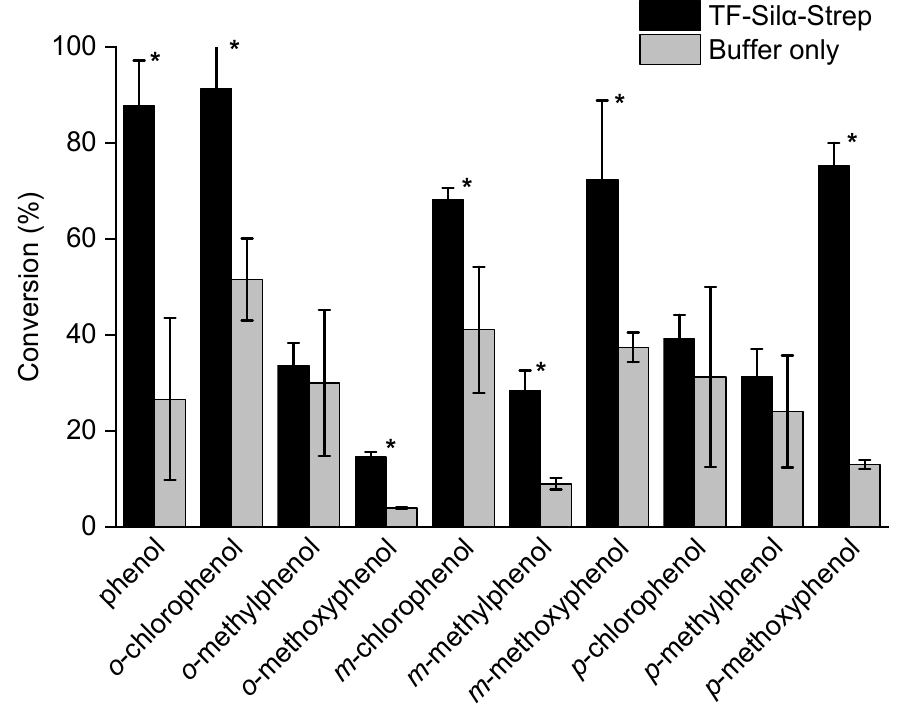
Figure 1. Graph of percentage conversions of phenols to the corresponding silyl ethers after 72 h. The error bars indicate standard deviations. A one-tailed Student’s t -test assuming unequal variance was performed, comparing each enzyme to its control. Comparisons resulting in a p < 0.05 were deemed to be significant and are marked with *.